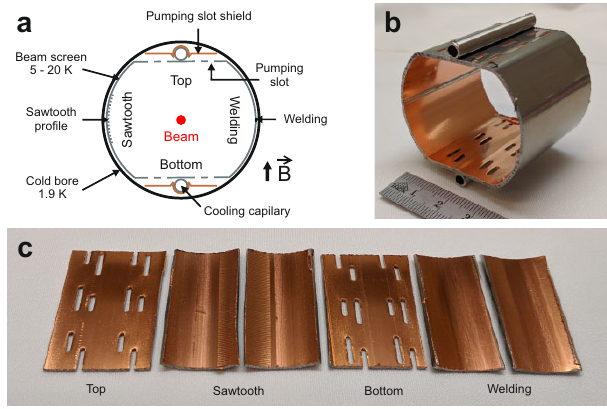
Fig. 1 LHC beam screen. a Schematic of the beam vacuum system in the LHC arcs with the orientation of the dipole magnetic fi eld B, b beam screen section collected for laboratory analysis, before, and c after cutting for fi tting into the experimental set-up. The identi fi cation name of the different beam screen sides is indicated in ( a , c ), where the welding side refers to the full lateral side and not only to the welding